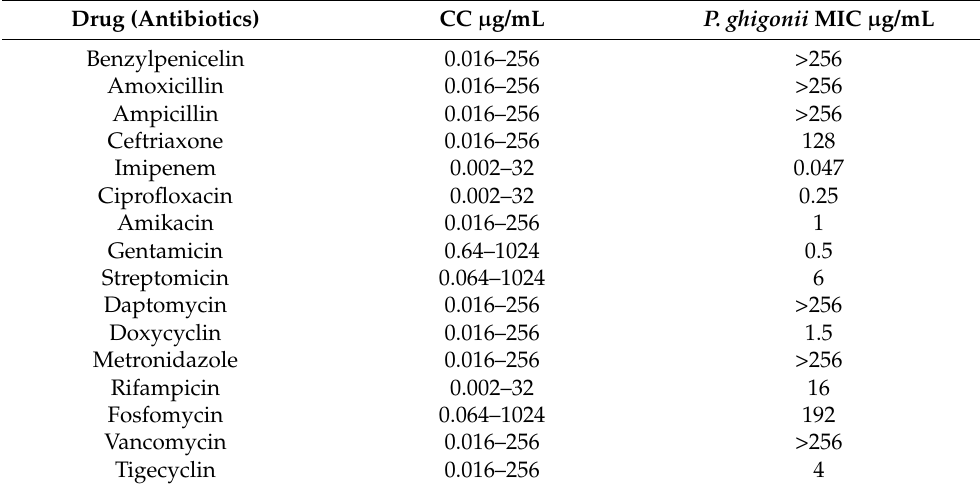
Table 6. Antimicrobial susceptibility and MIC values of strain Marseille-Q2390.